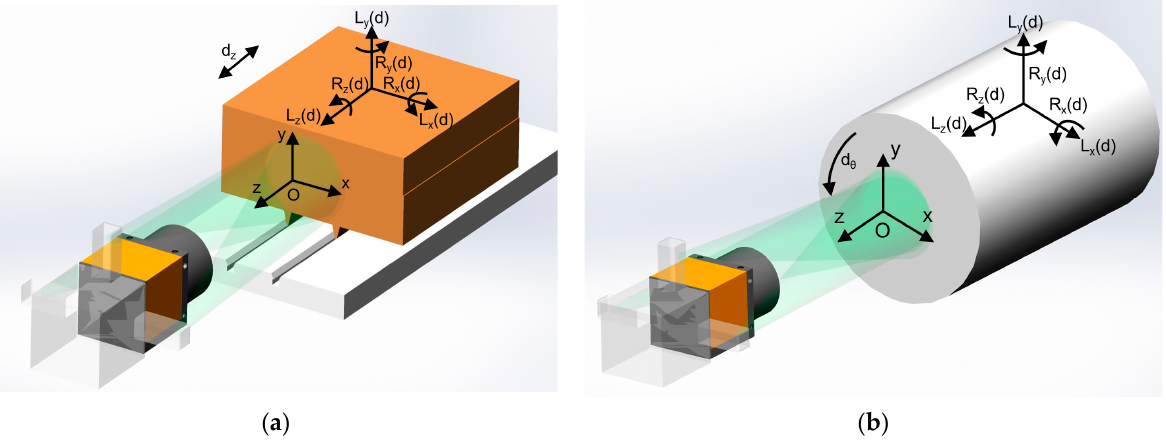
Figure 1. The setups of the DOF error measurement with DSPI for ( a ) linear guide and ( b ) rotary